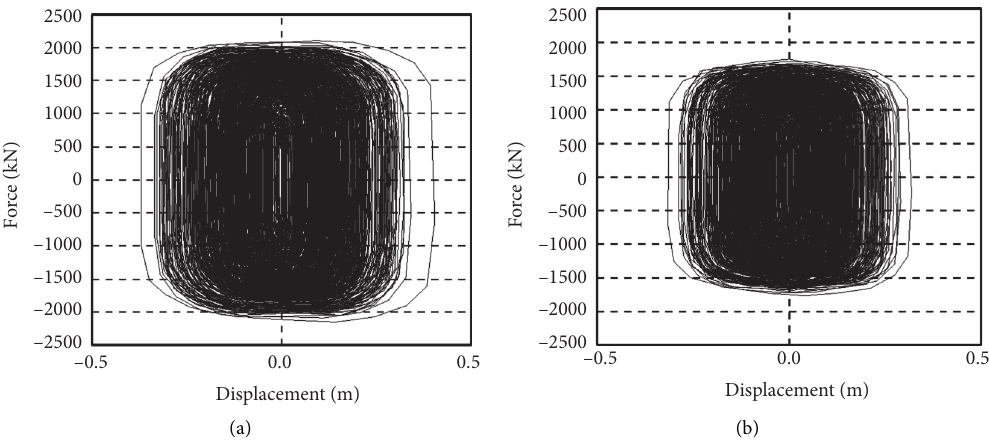
Figure 26: Hysteresis loops of zones 4 and 6 after iteration: (a) zone 4; (b) zone